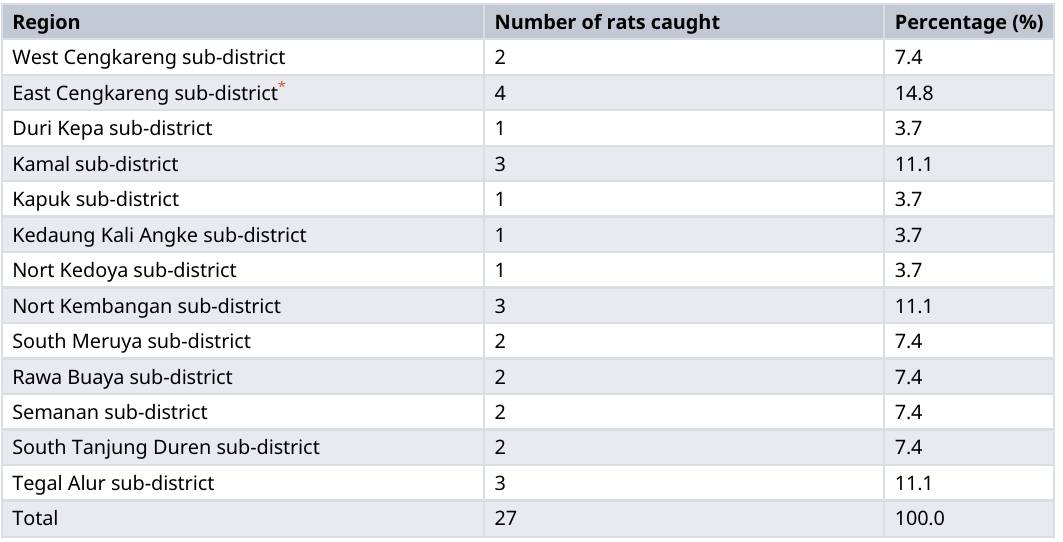
*The region was found more rats and